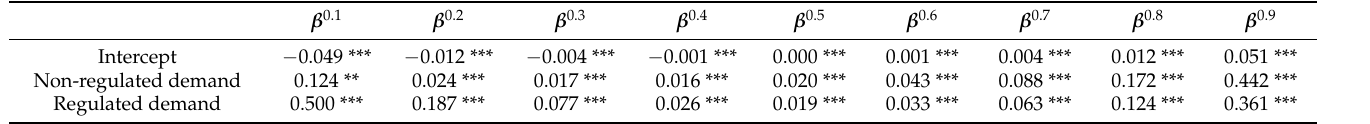
Table A1. Quantile regression coefficients for the different quantiles in 2018.